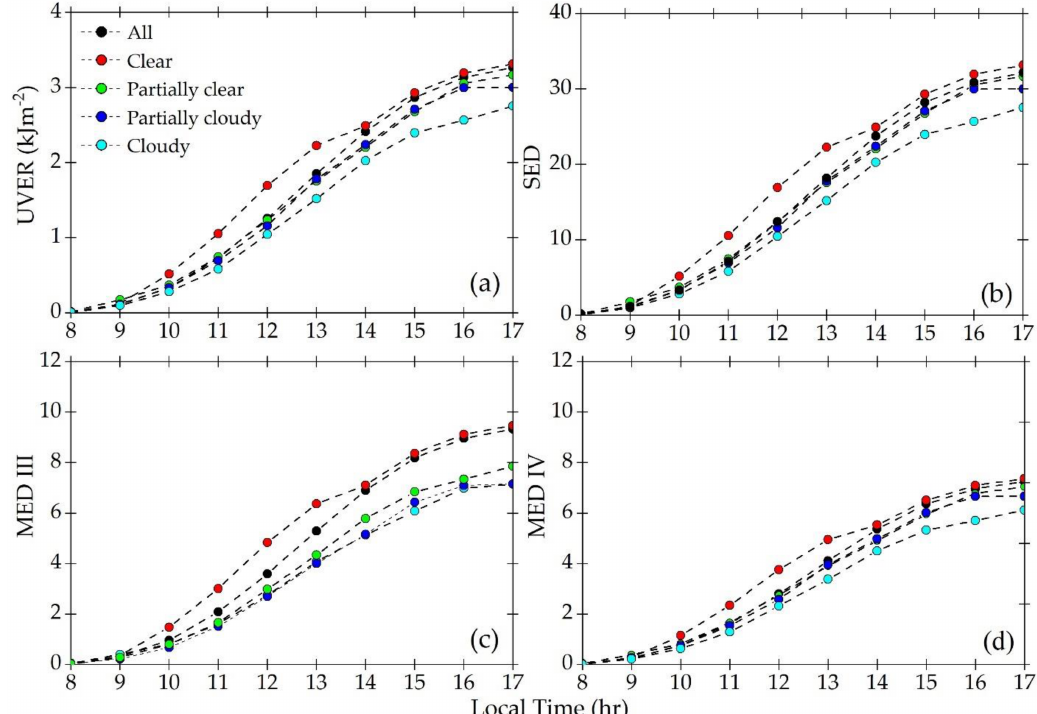
Figure 5. Accumulated hourly values of ( a ) UVER, ( b ) standard erythemal dose (SED), ( c ) minimum erythemal dose (MED) III, and ( d ) MED IV between 8:00 and 17:00 local time (LT) for all-sky, clear, partially clear, partially cloudy, and cloudy conditions observed in Santiago from 2015 to